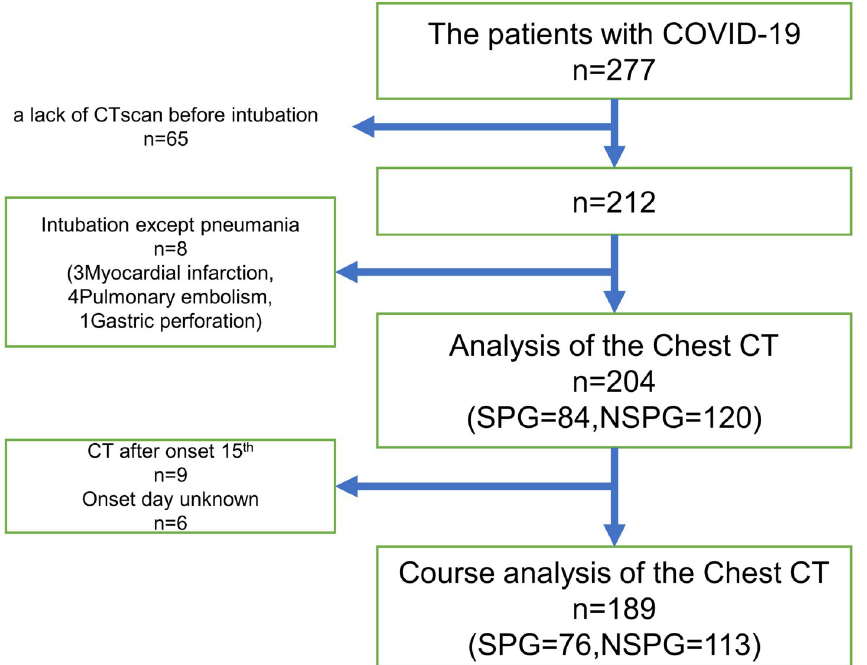
Fig 1. The study design of this COVID-19 study. SPG: severe pneumonia group (n = 84); NSPG: non-severe pneumonia group (n = 120).